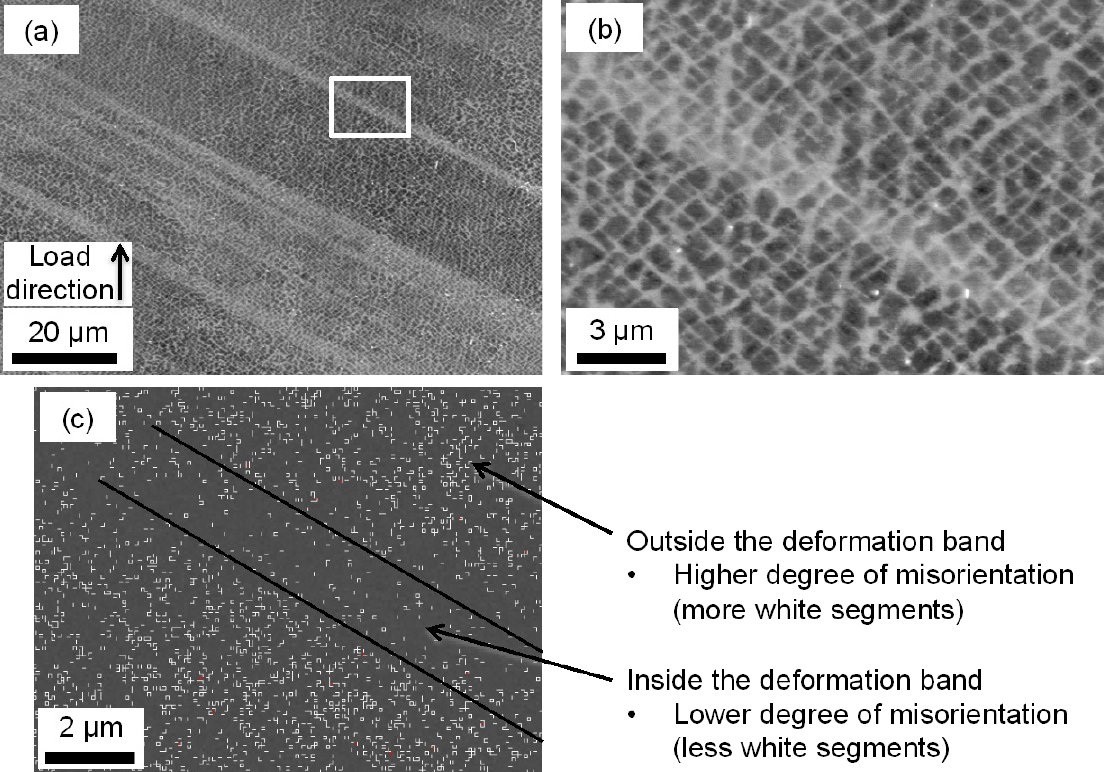
specimen subjected to compressive stress; ( a ) a backscattered electron image of deformation bands at 1200 times magnification; ( b ) same deformation band as in 〈 011 〉 ( a ) at 7000 times magnification; ( c ) EBSD map of such a deformation band, where each white segment corresponds to an orientation difference of